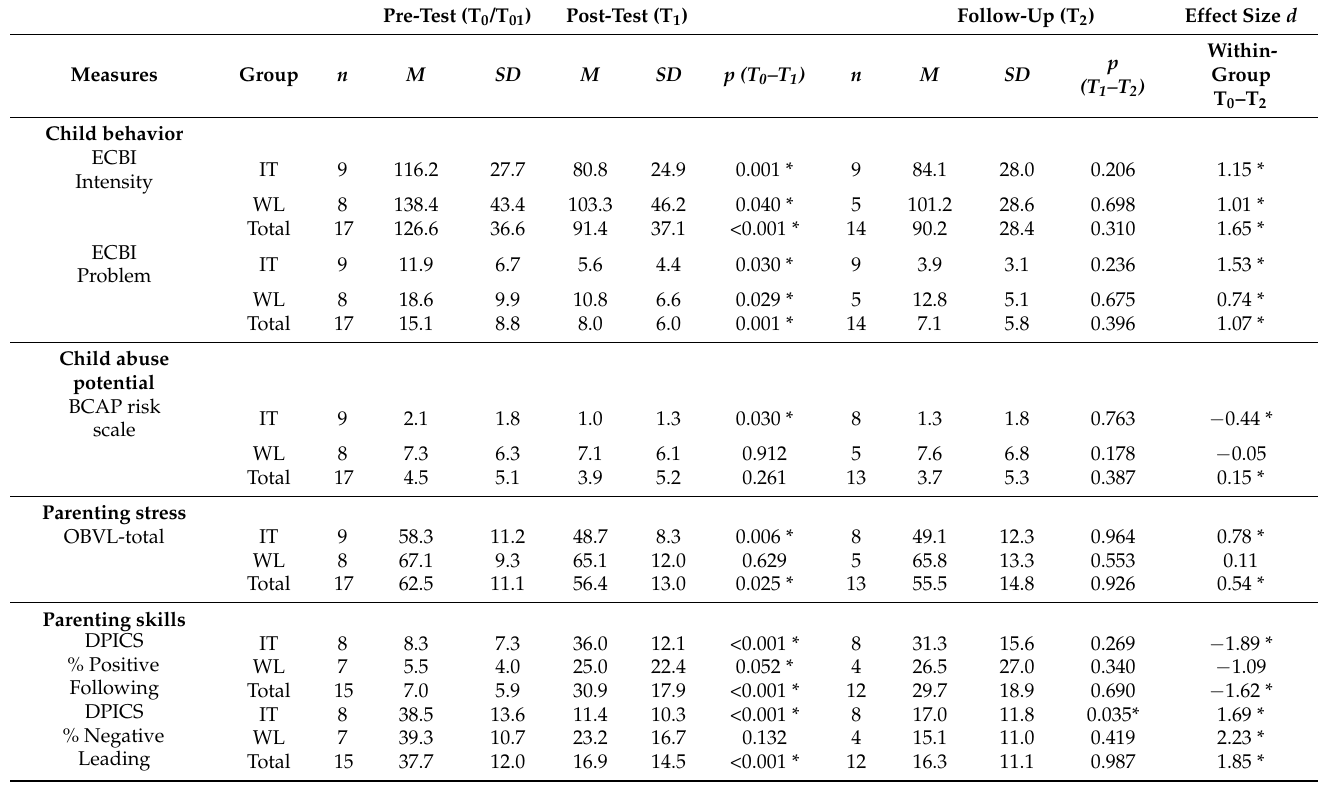
Table 3. Unadjusted means, effect sizes, and within- and between group comparisons for the total sample. Pre-Test (T 0 /T 01 ) Post-Test (T 1 ) Follow-Up (T 2 ) Effect Size